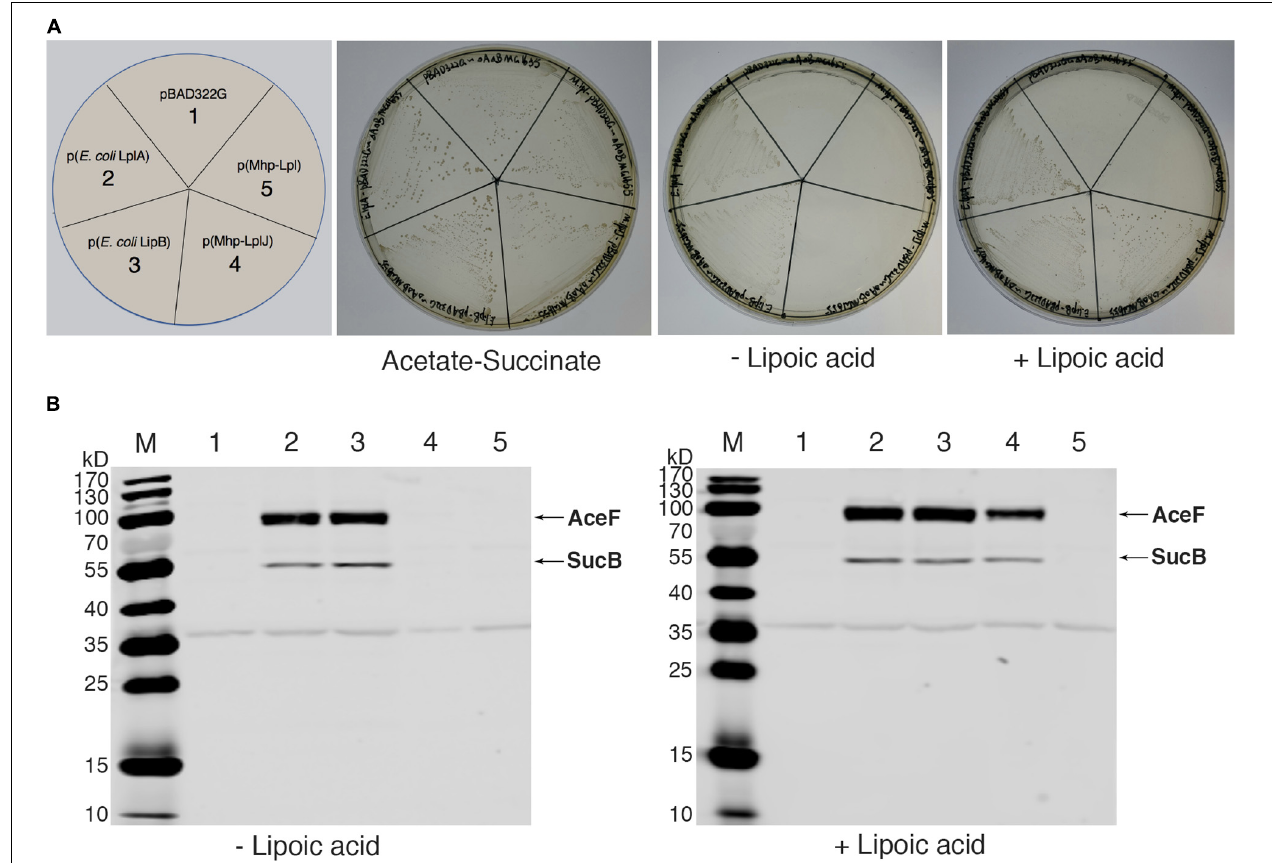
FIGURE 5 | Complementation of an E. coli lipoyl-deficient strain with Mhp-LplJ and Mhp-Lpl. (A) Growth of strain DE0626 (MG1655 (cid:49) lplA (cid:49) lipB ) transformed with pBAD322G-derived plasmids expressing the indicated genes. The complementation assays were performed on M9 minimal agar containing 0.2% L -arabinose. The control strains were the strain DE0626 transformed with the empty vector pBAD322G or derived plasmids expressing the indicated E. coli genes. The complemented strain DE0626 expressing E. coli LplA grew well on M9 minimal plate without lipoic acid because LplA could scavenge free octanoic acid from E. coli cytosol, and the octanoyl group was converted to lipoyl group under the catalysis of LipA. (B) Western blot analyses with Anti-LA to determine levels of lipoylation in complemented strains. The strains were grown for 24 h in Luria broth supplemented (+) or not (–) with lipoic acid. Lane M is the molecular weight ladder. The strains of lanes 1–5 corresponded to those in (A) . The protein of bands is